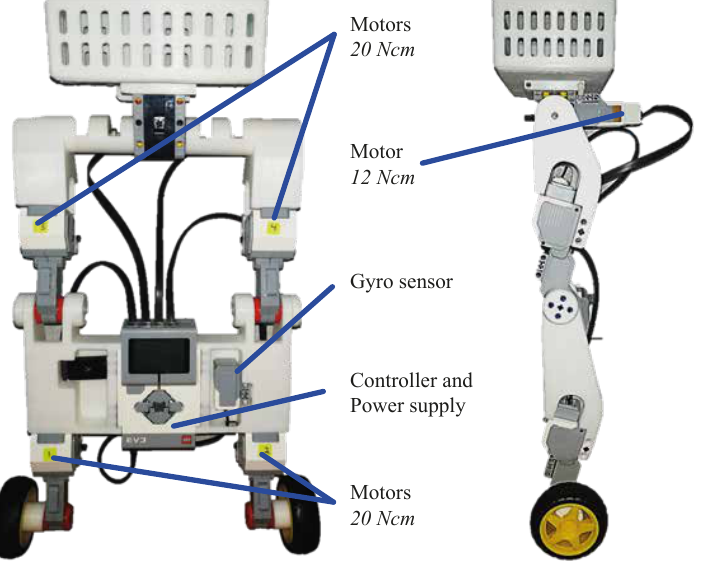
Figure 2. Assembly of the mobile robot.